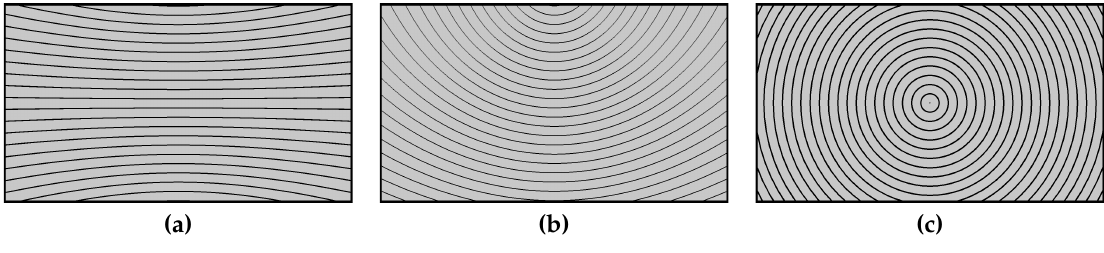
Figure 2. Examples of the theoretical conic shaped tracks, for different tilt angles α . ( a ) α = 0, ( b ) α = π , ( c ) α = π 2 4